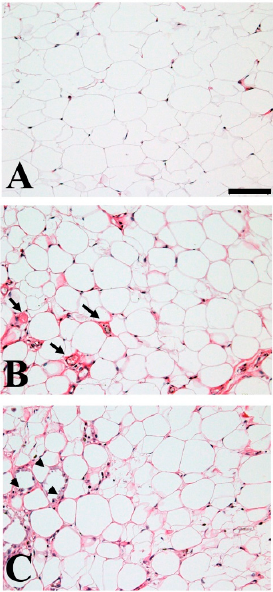
Figure 1. Morphological alternation of human adipose tissue by inflammation. Adipose tissue dynamically changes by excess nutrition, overweight/obese. During the process of hypertrophy, heathy adipose tissue ( A ) may increase vascularity ( B ) arrow indicates the vascular vessels, furthermore, may harbor inflammation ( C ) arrow head indicates the macrophage infiltration. Adiponectin and intelectin ‐ 1 secretion from adipocyte or adipose stromal cells are decreased by hypertrophy, instead pro ‐ inflammatory adipokines—i.e., Leptin secretion—is